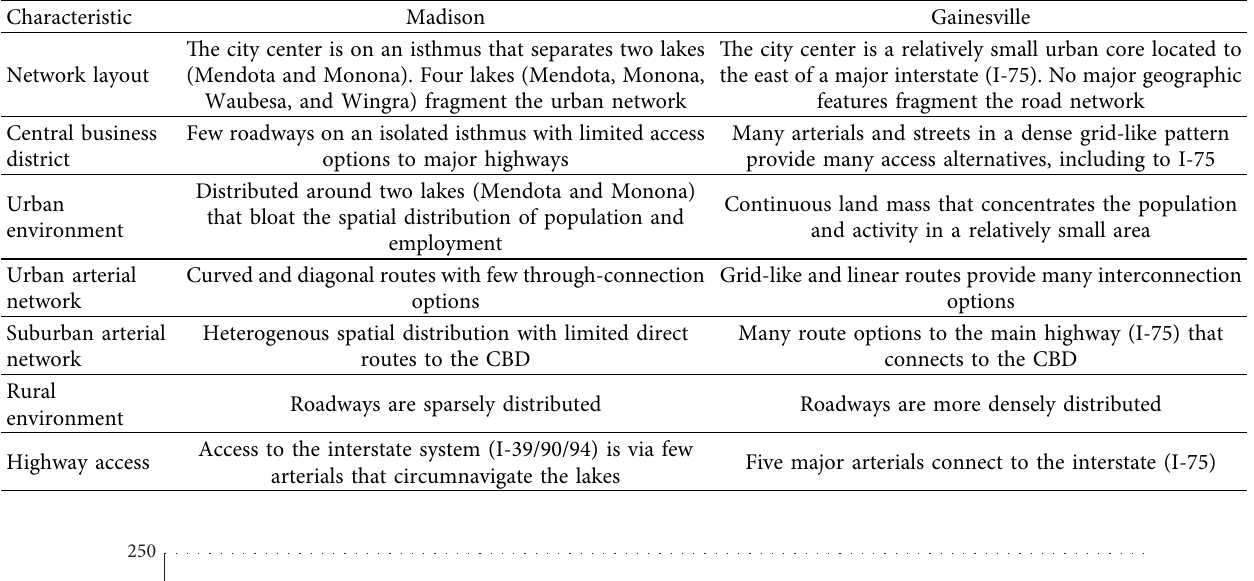
Table 5: Comparison of model networks.